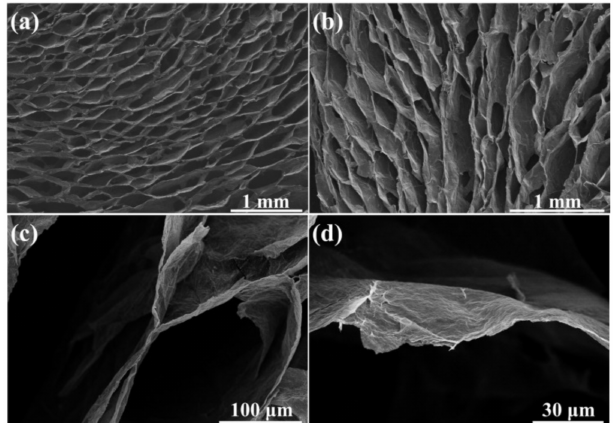
Figure 3. Scanning electron microscope (SEM) images of ( a ) cross-section and ( b ) vertical-section of the compressible rGO aerogel; ( c , d ) Cross-section of the compressible rGO aerogel at differ- ent